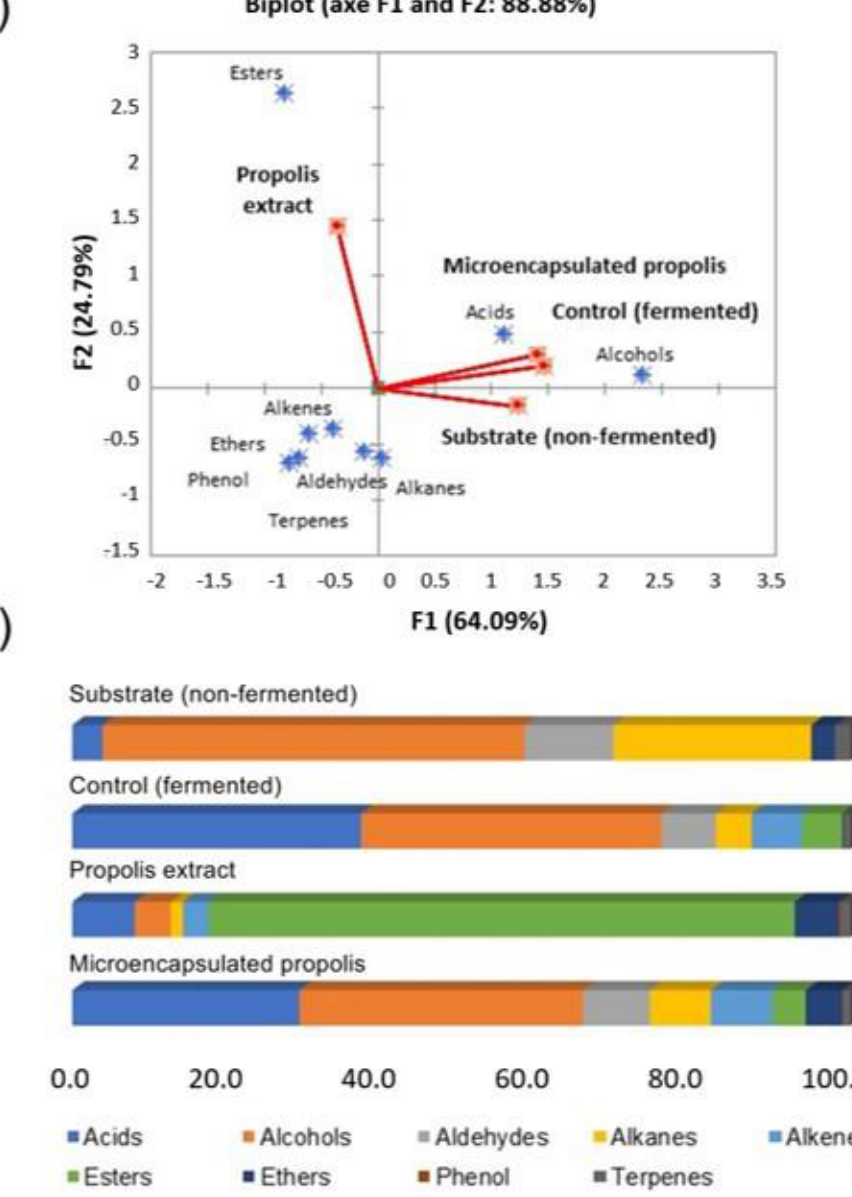
Figure 5. ( a ) Principal component analysis of chemical groups and assays. ( b ) Area percentage of volatile groups identified by GC-MS. [Non-dairy matrix (N-DM) : 1 Control —consists only of the fermented beverage (N-DM); 2 Extract —beverage (N-DM) with propolis extract (DPE); 3 Microcap- sule —beverage (N-DM) with microencapsulated propolis (D.M.P.)].